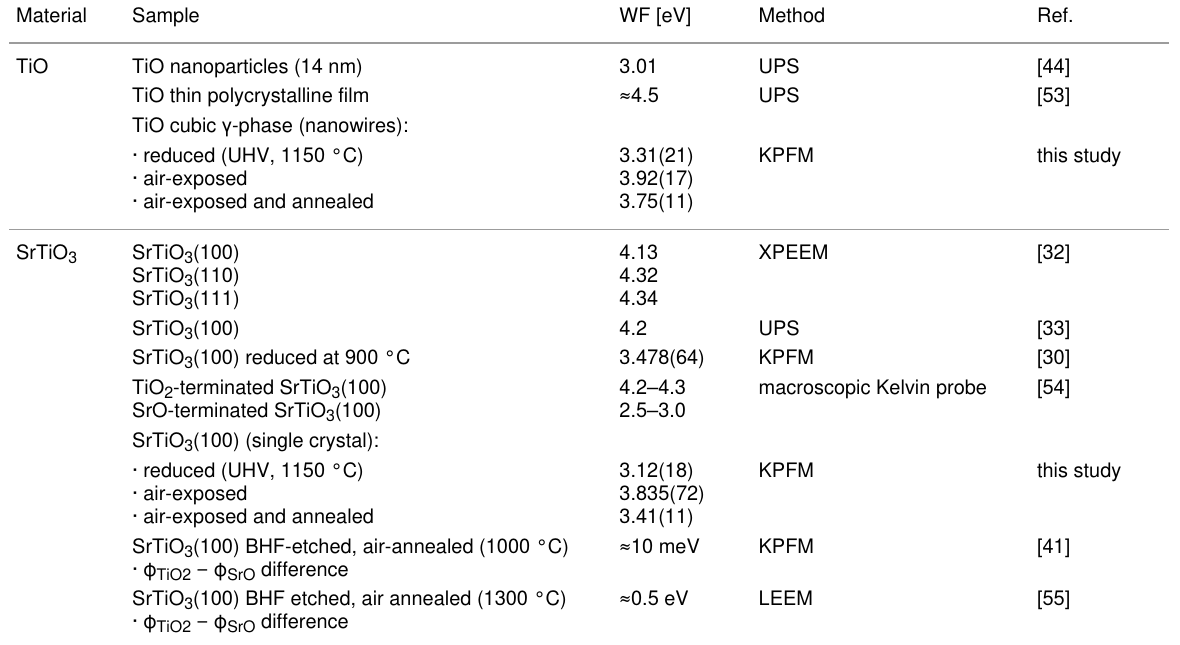
Table 1: Comparison between the literature values and the obtained experimental results of TiO and SrTiO 3 work functions (WF). Material Sample WF [eV] Method Ref.